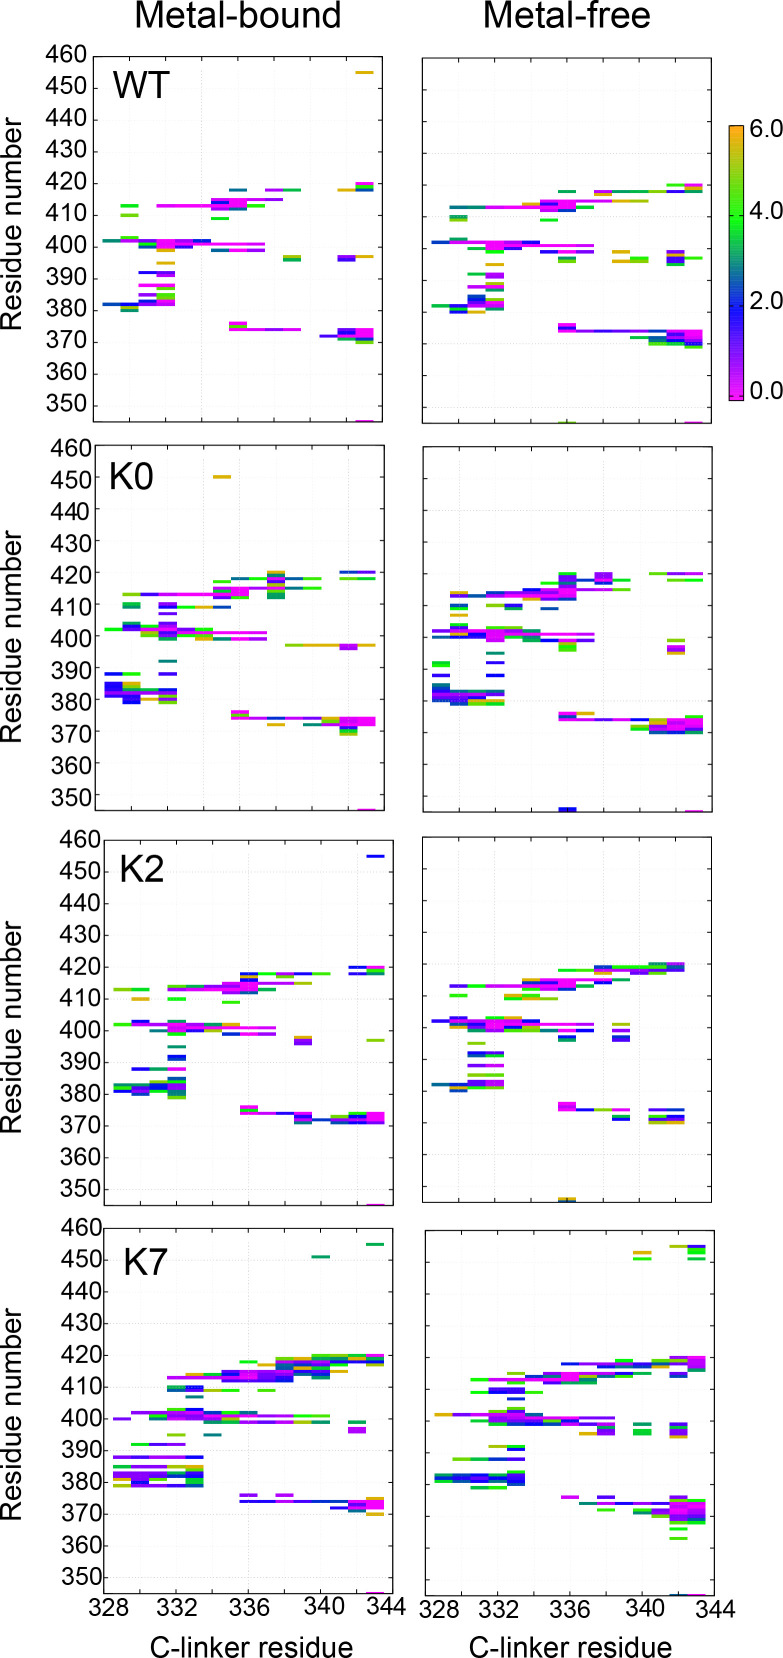
Probabilities of residue–residue contacts between the C-linker and RCK1 N-lobe of the same chain.See Materials and methods for additional details.